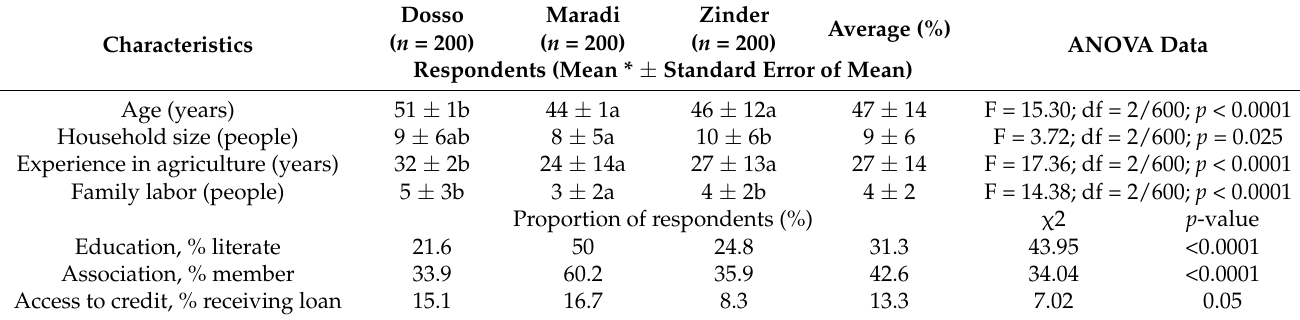
Table 2. Characteristics of respondents to the survey conducted in Dosso, Maradi, and Zinder regions of Niger.